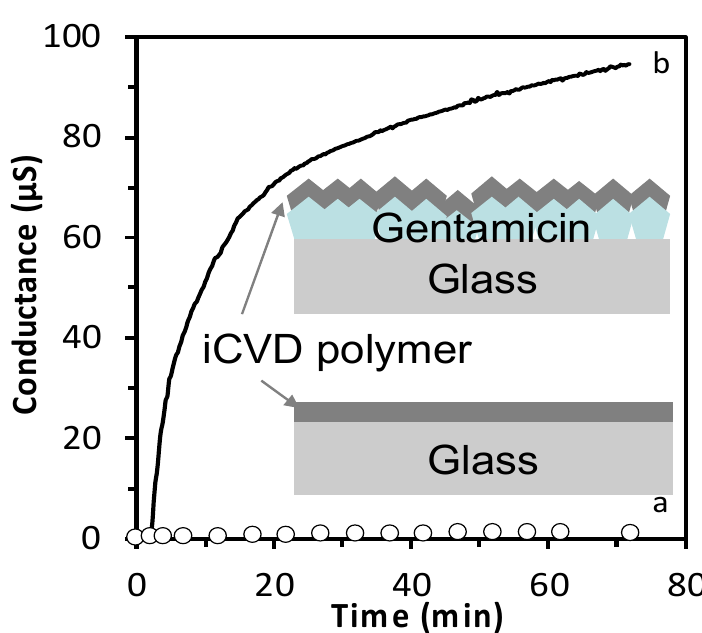
Figure 3. Conductance variation due to the release test from (a) initiated chemical vapor deposition (iCVD) coating alone (white dots) and (b) drug layer with iCVD coating on top (continuous line). Drug layer obtained by drop casting (drop volume = 300 µ L, [Gent] = 10 mg / mL), iCVD coating thickness ~200 nm with an EGDMA volume fraction of 46%, immersed in distilled water.